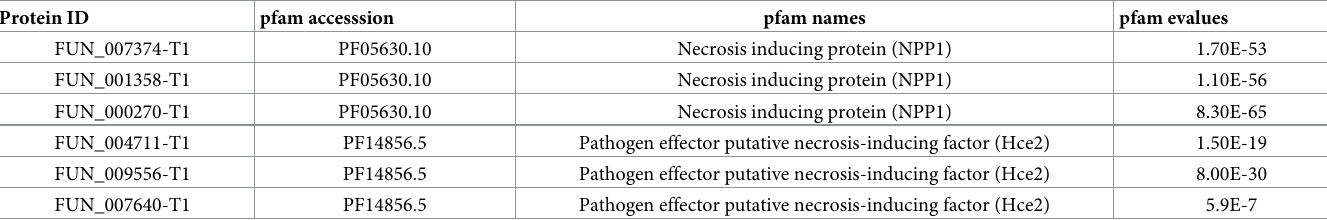
Table 3. Potential necrosis-inducing toxins encoded in the F . oxysporum f. sp. albedinis genome. Protein